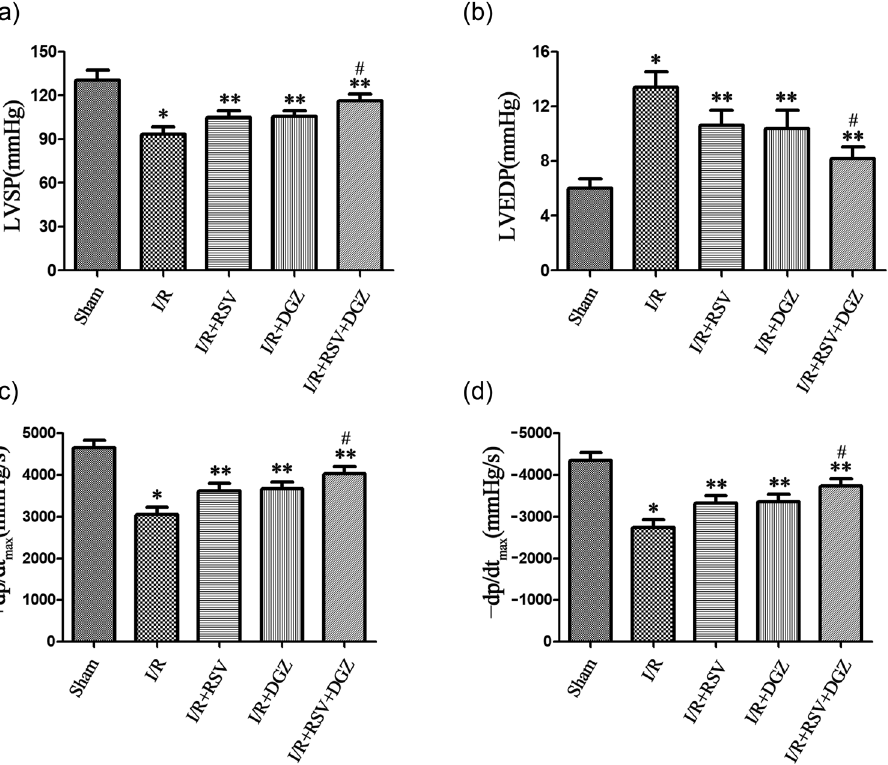
Figure 1: Hemodynamics in rats subjected to 30 min ischemia and 120 min of reperfusion for each group ( mean ± SD, n = 5 ) . * p < 0.001 compared with Sham; ** p < 0.05 compared with I/R; # p < 0.05 compared with I/R + RSV or I/R + DGZ. LVSP: left ventricular systolic pressure; LVEDP: left ventricular end - diastolic pressure; + d p /d t max : maximal rate of increase left ventricular pressure; − d p /d t max : maximal rate of decrease left ventricular pressure. Sham: sham operated group; I/R: ischemia/reperfusion group; I/R + RSV: ischemia/reperfusion + rosuvastatin group; I/R + DGZ: ischemia/reperfusion + dapagli fl ozin group; I/R + RSV + DGZ: ischemia/reperfusion + rosuvastatin + dapagli fl ozin